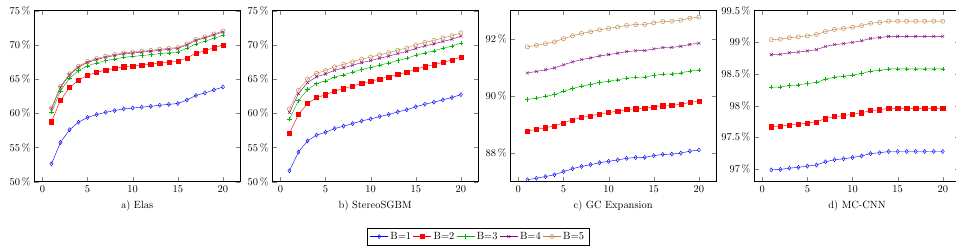
Figure 9. Values of the BMB metric when EEMM was used with algorithms: ( a ) ELAS, ( b ) Stere- oSGBM, ( c ) GC Expansion and ( d )